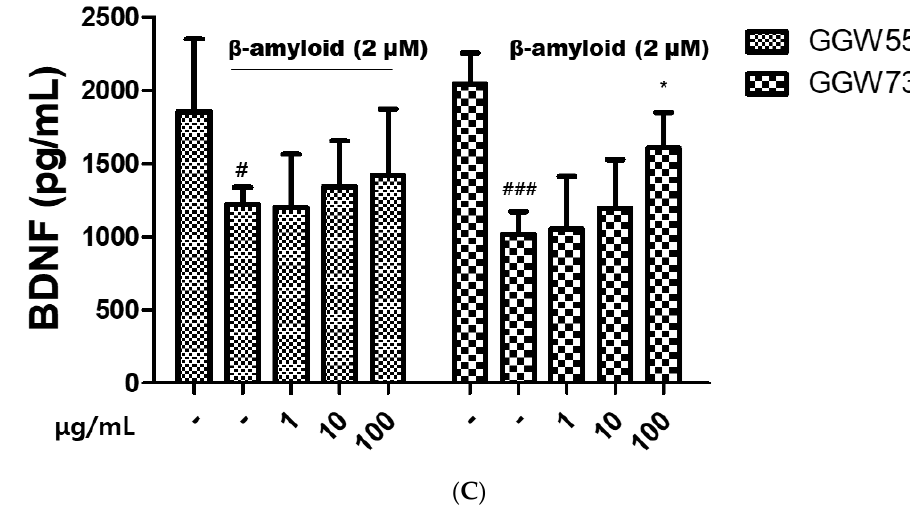
Figure 3. The regulatory effect of GGW on Aβ− stimulated ACHE pathway on SH-SY-5Y cells. The regulatory effect of GGW55 and GGW73 on Aβ− stimulated ACHE pathway on SH-SY-5Y cell. The cells were treated with GGW55 and GGW73, after 4 h Aβ (2 μM) were treated for 24 h. ( A ) ACHE mRNA expression was measured real-time qPCR. ( B ) BACE − 1 mRNA expression was measured with real-time qPCR. ( C ) BDNF secretion was measured with ELISA. All values are expressed as the mean ± S.E.M from three independent experiments.; # p < 0.05 compared with none-treatment group; ## p < 0.005 compared with none-treatment group; ### p < 0.001 compared with none-treatment group; * p < 0.05 compared with none-treatment group, *** p < 0.001 compared with only Aβ− treatment group.